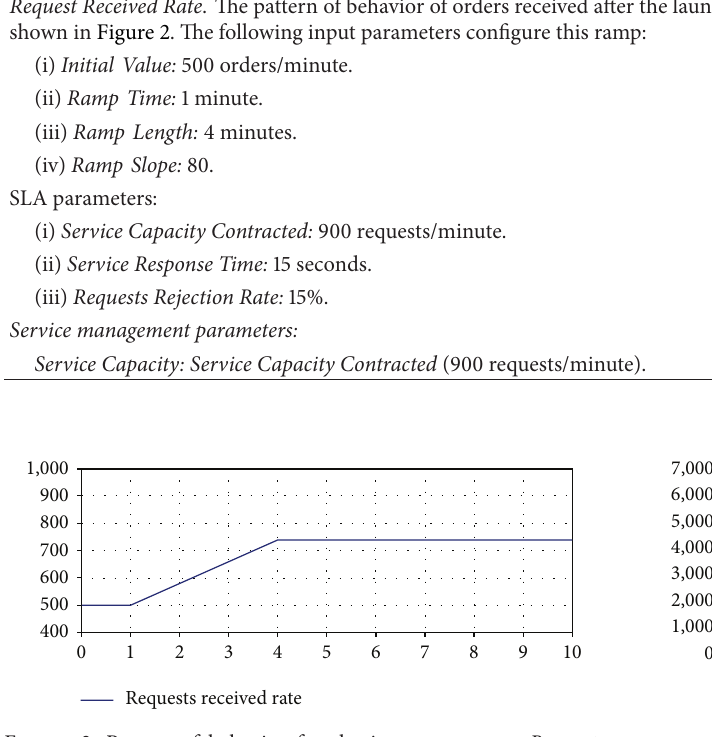
Figure 5: Output variable Requests Validated (E3).